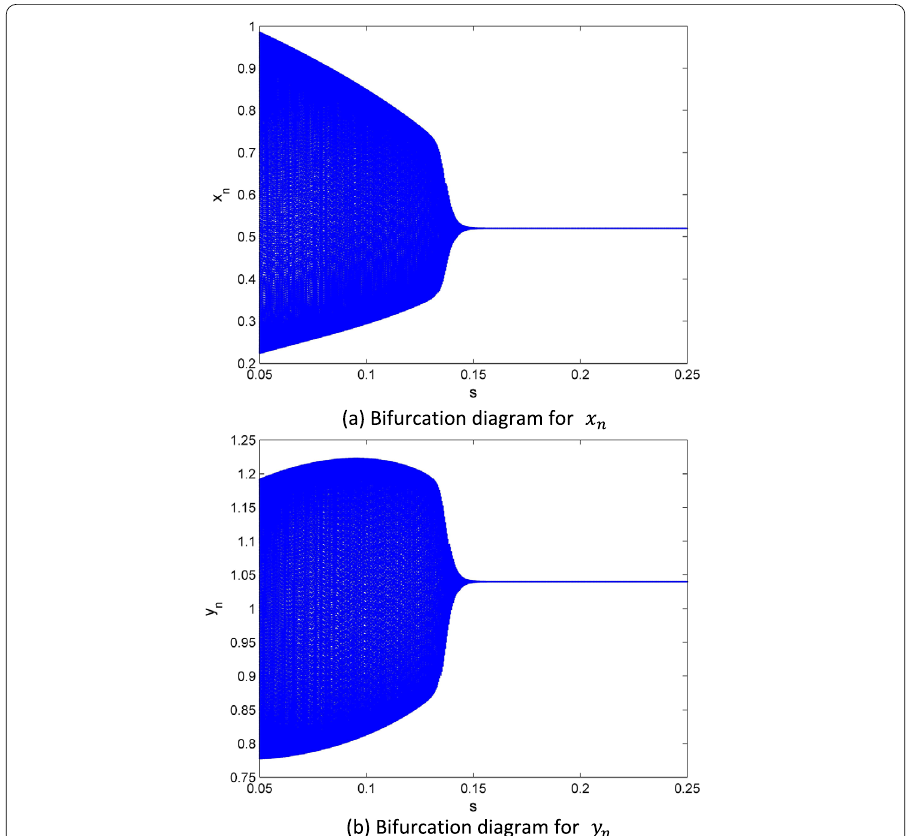
Figure 4 Bifurcation diagrams for system (3) with r = 1.2, k = 1.5, α = 0.45, β = 0.2, h = 0.5, δ = 0.1, s ∈ [0.05,0.25] and ( x 0 , y 0 ) =